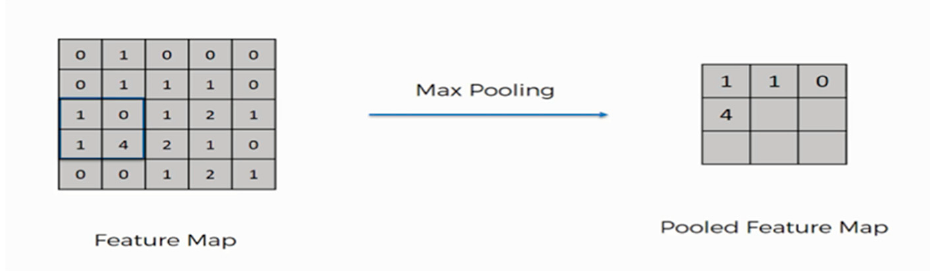
Figure 17. Max pooling, 2-pixel strides [57].